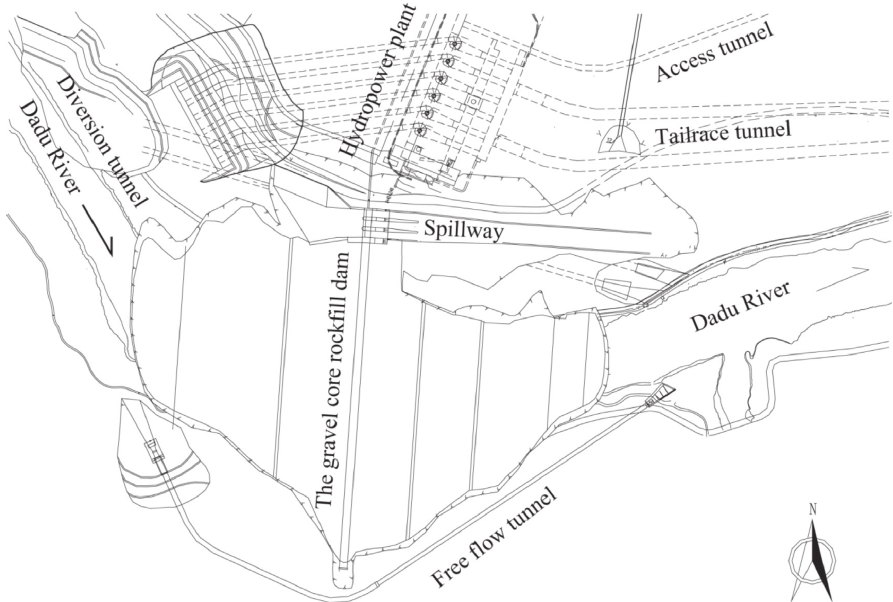
Figure 5: The layout of the Pubugou hydropower station.